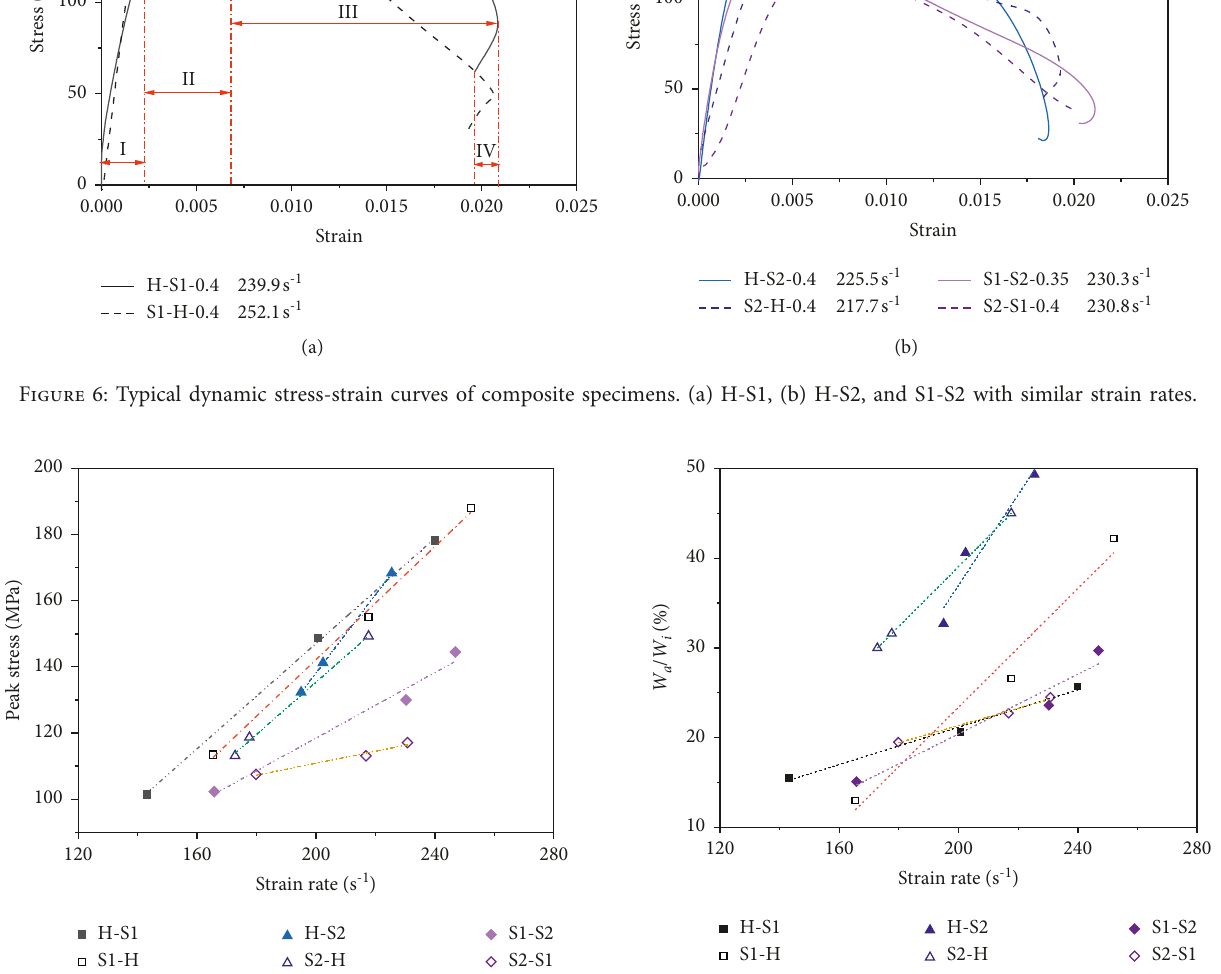
Figure 7: Relationship between peak stress and strain rate. Figure 8: Variations of energy absorption rate versus strain